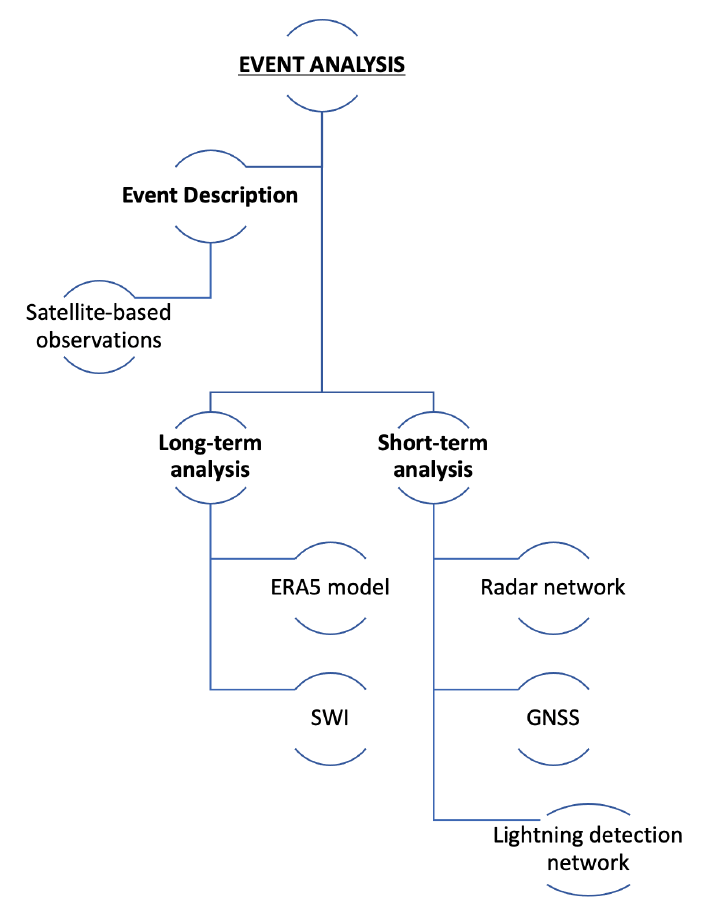
Figure 5. Concept map of applied